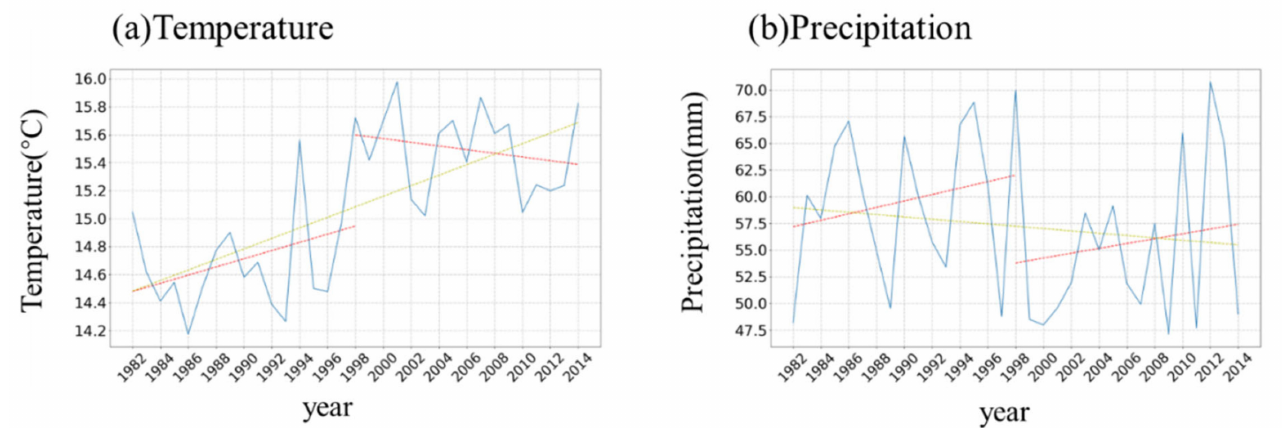
Figure 4. Time series of regional average temperature ( ◦ C) and precipitation (mm). The red line in the figure represents the trend from 1982–1998 and 1998–2014, the blue line represents the regional average of temperature and precipitation from 1982-2014, and the yellow line represents the overall trend from